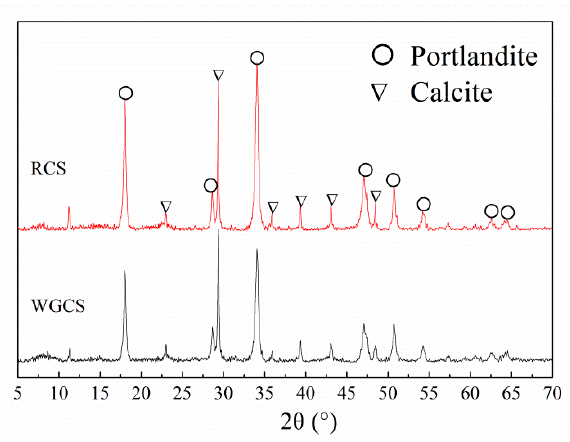
Figure 3. XRD patterns of RCS and WGCS.